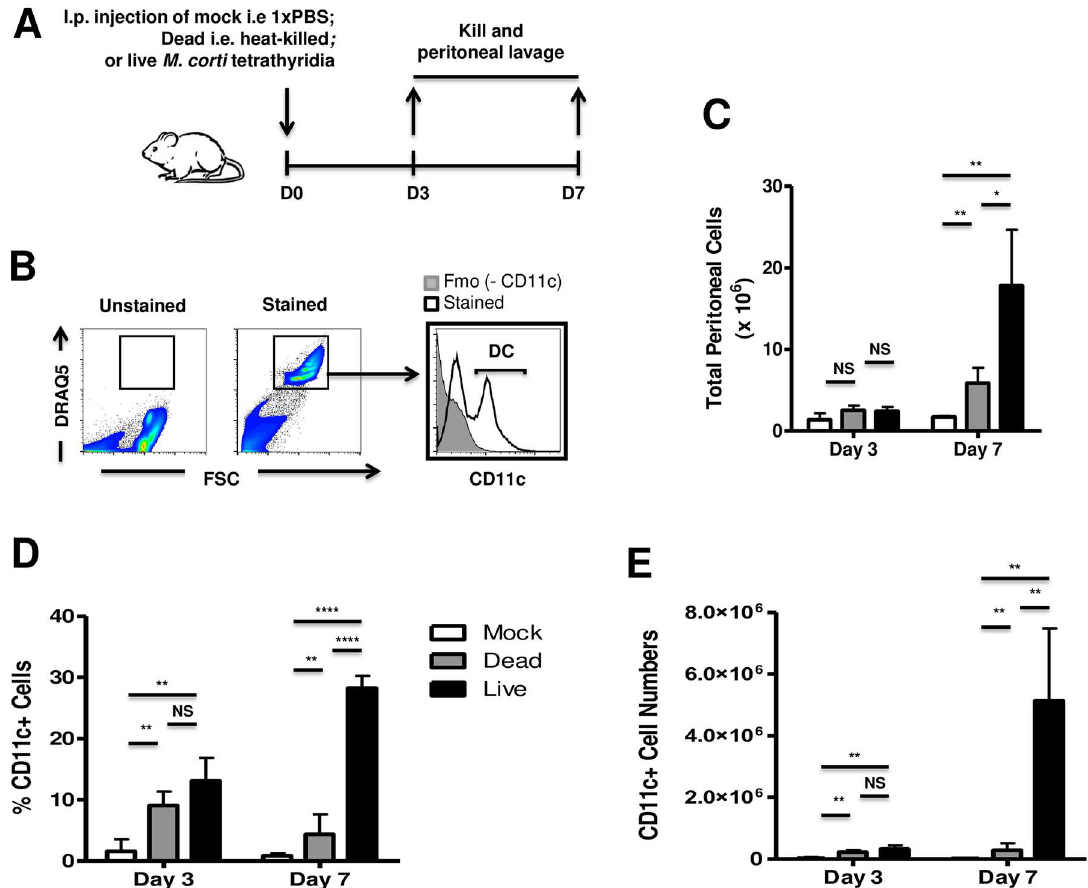
Fig 1. M . corti metacestode larvae (tetrathyridia) elicit a significant recruitment of host CD11c+cells in vivo . (A) Schematic showingexperimental set-up. (B) Gating strategy for CD11c+ cells in the peritoneal exudate cells. (C) Total peritoneal cells from mock–injected mice and mice injected i.p with heat-killedor live M . corti larvae were determinedat day 3 and day 7 followinginjection. (D) Percentages of peritoneal CD11c+ cells at day 3 and day 7 post-injection. (E) Total peritoneal CD11c+ cell numbers at day 3 and day 7 post-injection. Data are means ± SD of values from 4–5 mice per group assayed individually. p > 0.05, NS; p < 0.05, * ; p < 0.01, ** ; p < 0.001, *** ; p (cid:20) 0.0001, ****